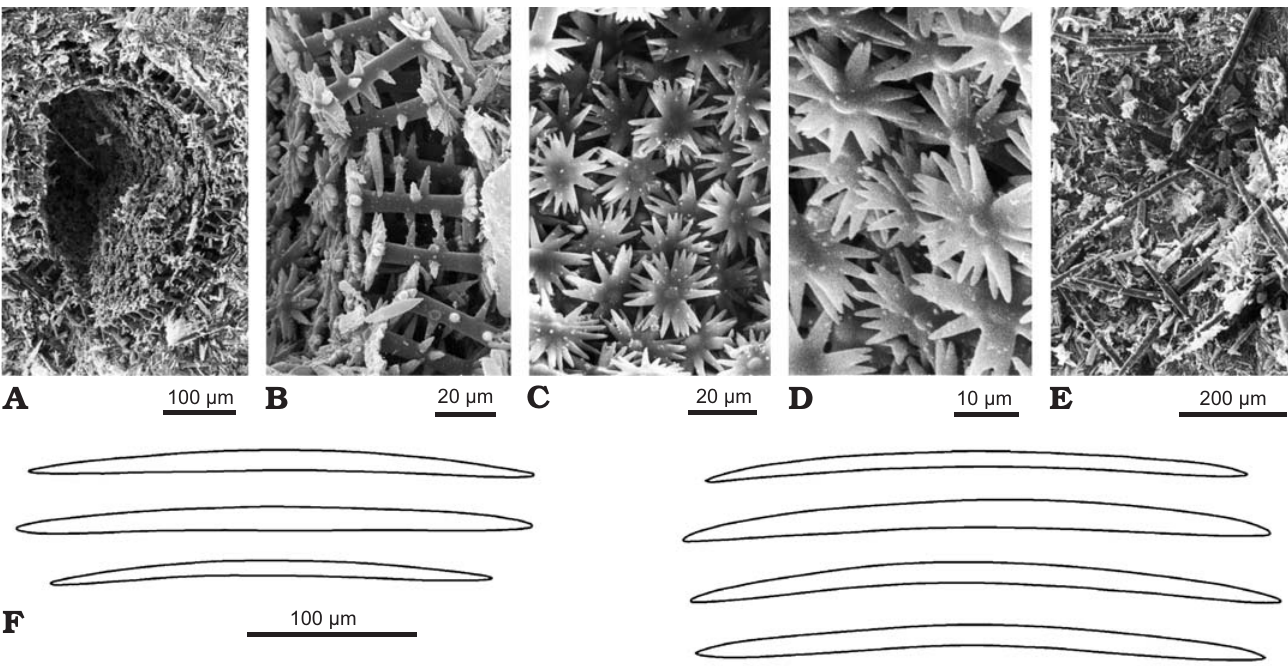
Fig. 20. Ephydatia chileana Pisera and Sáez, 2003, Spongillida: Spongillidae, ZPAL Pf12; late Miocene, Quillagua Formation, Atacama region, Chile. A . Gemmule (cross-section). B . Gemmular theca with radial gemmuloscleres bearing strong spines on the shaft (cross-section). C , D . Inner surface of the theca with proximal rotules of gemmuloscleres. E . Diatomite with loose oxeas. F . Drawings of loose megascleres from the sample with gemmules. A–E, SEM images. Modified from Pisera and Sáez Type locality : Quillagua Formation, Atacama region, Chile.